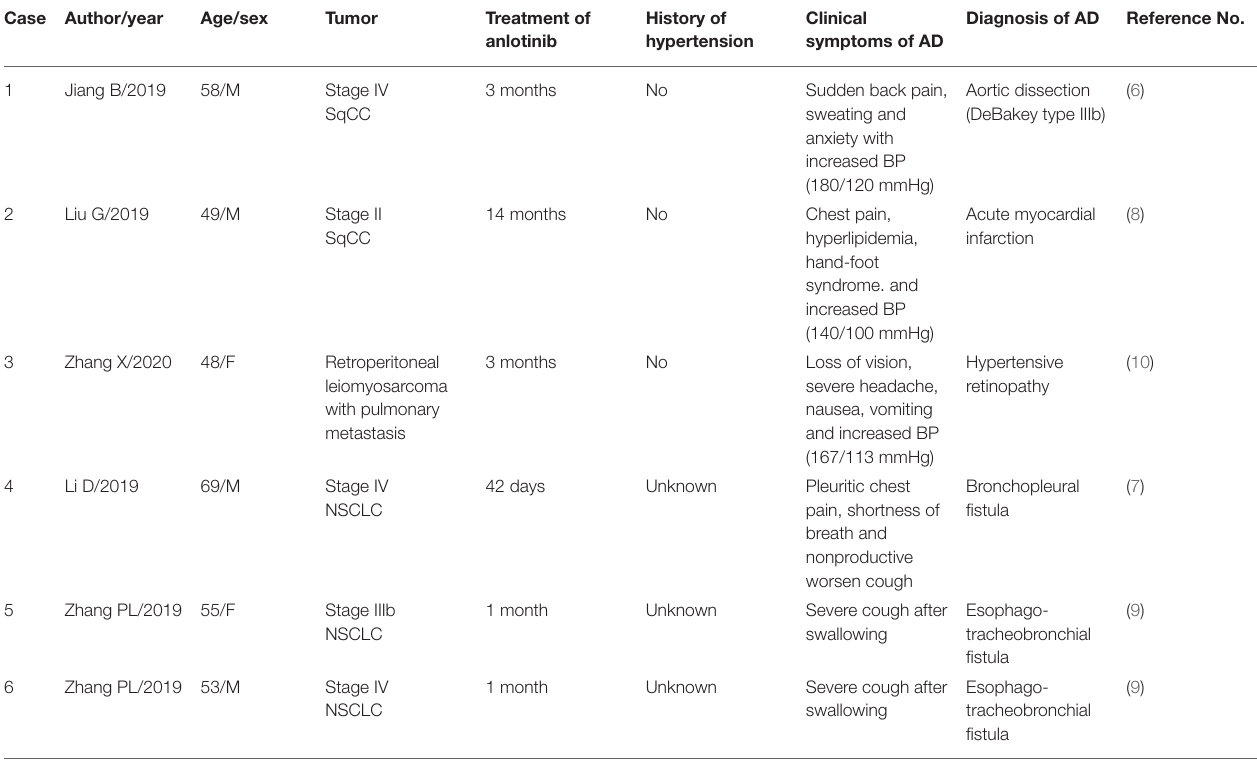
TABLE 1 | Summary of rare adverse effects induced by anlotinib.